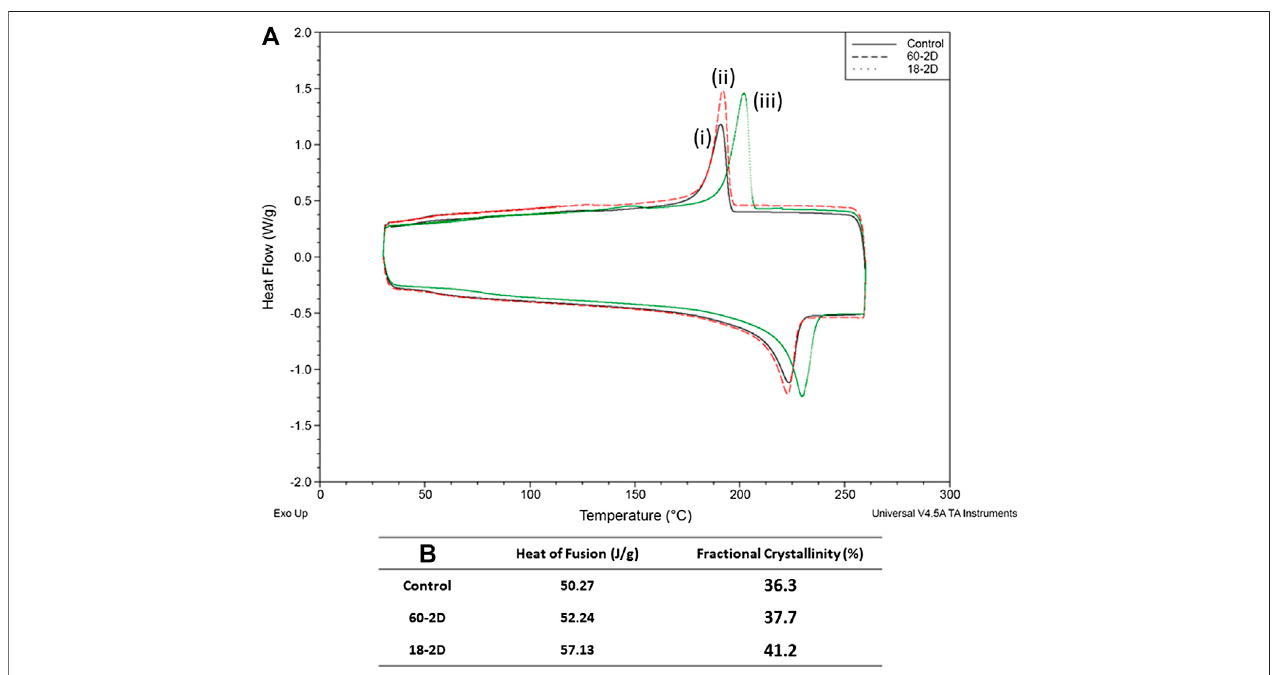
FIGURE 6 | Degree or crosslinking. Differential Scanning Calorimetry (DSC) data. (A) DSC of (i) control, (ii) 60-2D, and (iii) 18-2D. Data is shown for the second heating and cooling cycle. (B) Heat of fusion and fractional crystallinity of the samples. n (cid:2) 1 for all groups.